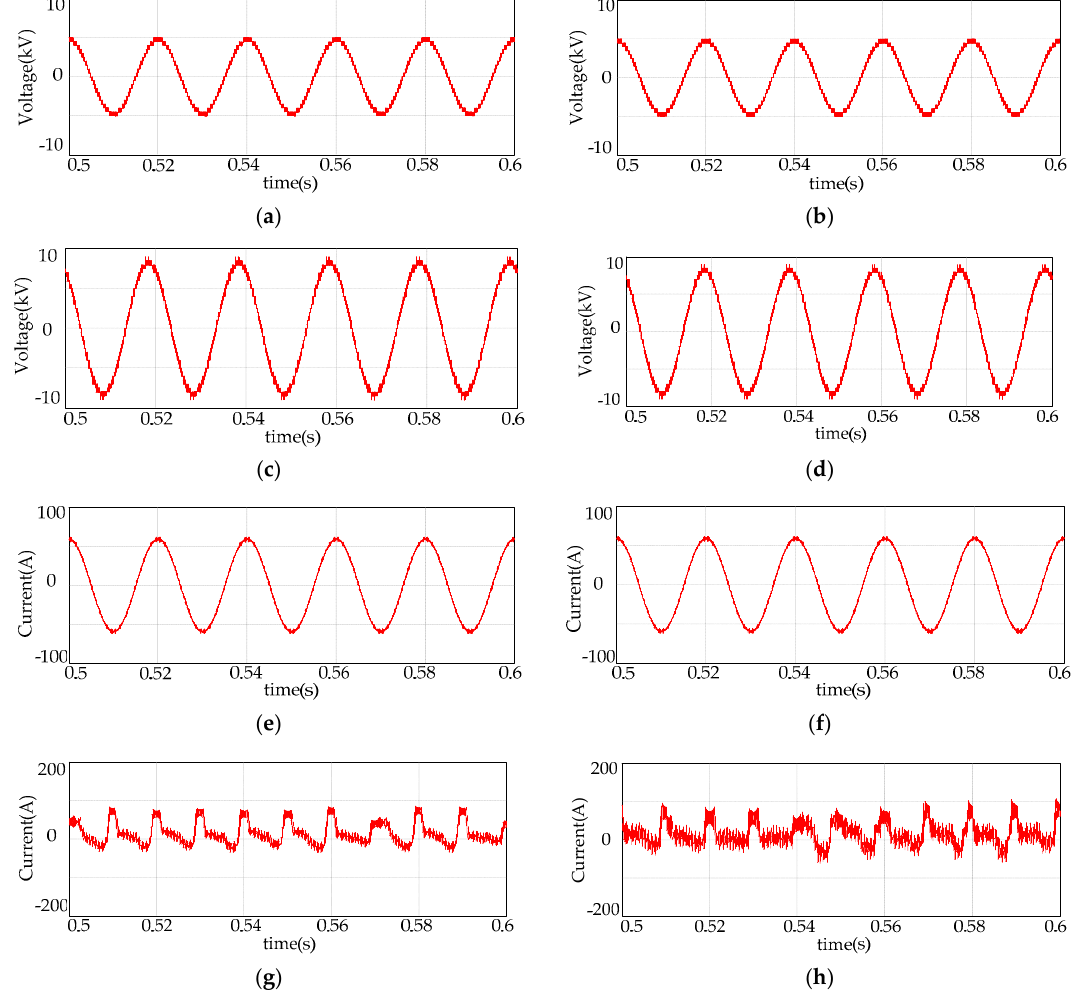
Figure 8. Comparison of simulation waveforms between the DCPDPWM and PSCPWM methods with output voltage harmonics minimization scheme: ( a ) phase voltage of DCPDPWM; ( b ) phase voltage of PSCPWM; ( c ) line-to-line voltage of DCPDPWM; ( d ) line-to-line voltage of PSCPWM; ( e ) phase current of DCPDPWM; ( f ) phase current of PSCPWM; ( g ) circulating current of PDPWM; and ( h ) circulating current of PSCPWM.